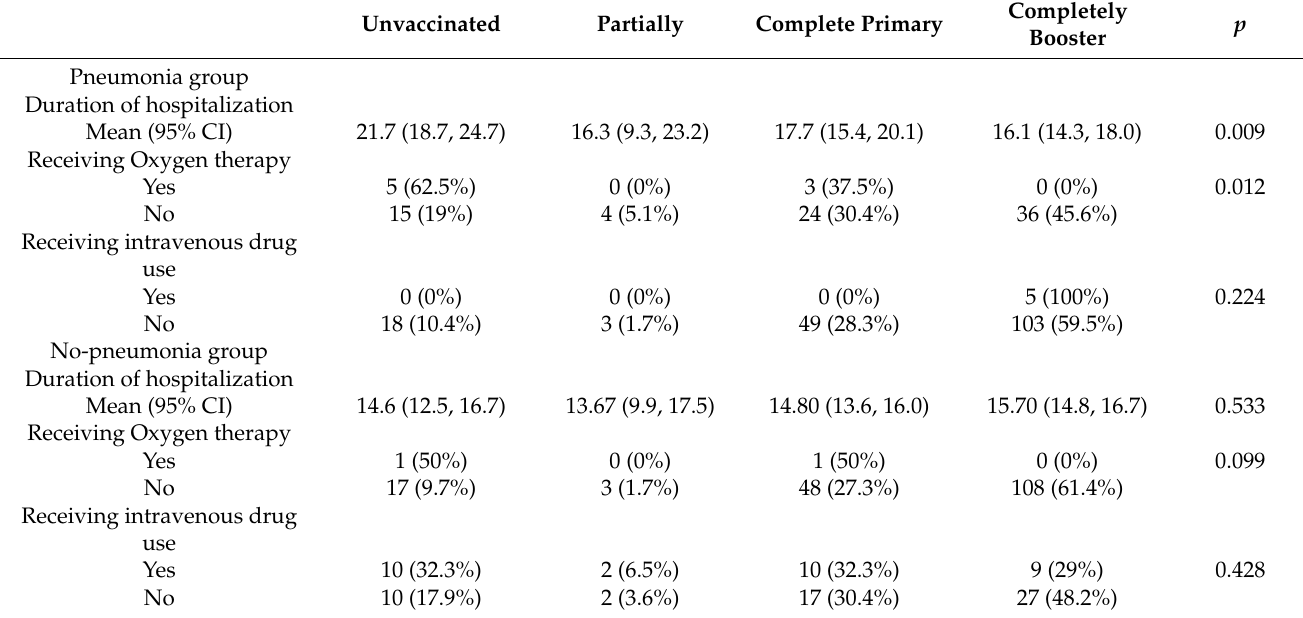
Table 3. Association between vaccination and medical resources stratified by disease severity. Unvaccinated